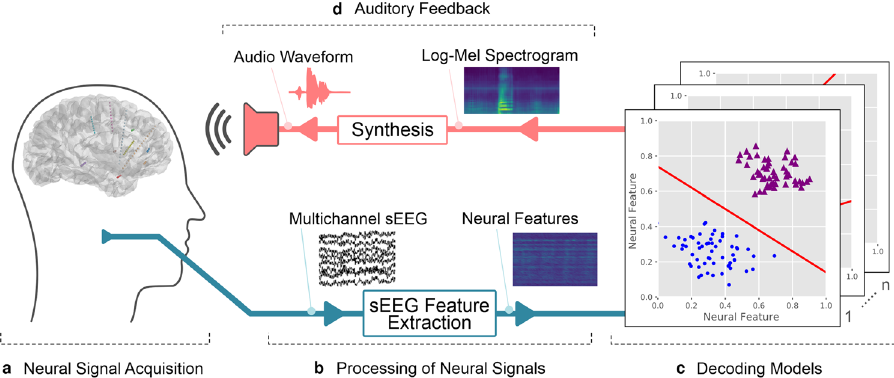
Fig. 2 Schematic overview of our proposed real-time synthesis approach. a Invasive brain signals are acquired through implanted sEEG electrodes. b Multichannel signals are processed to extract the high-gamma power. c Linear decoding models are used to estimate a spectral representation ( d ) which is synthesized into an audible speech waveform using the Grif fi n – Lim algorithm and presented to the patient as real-time auditory